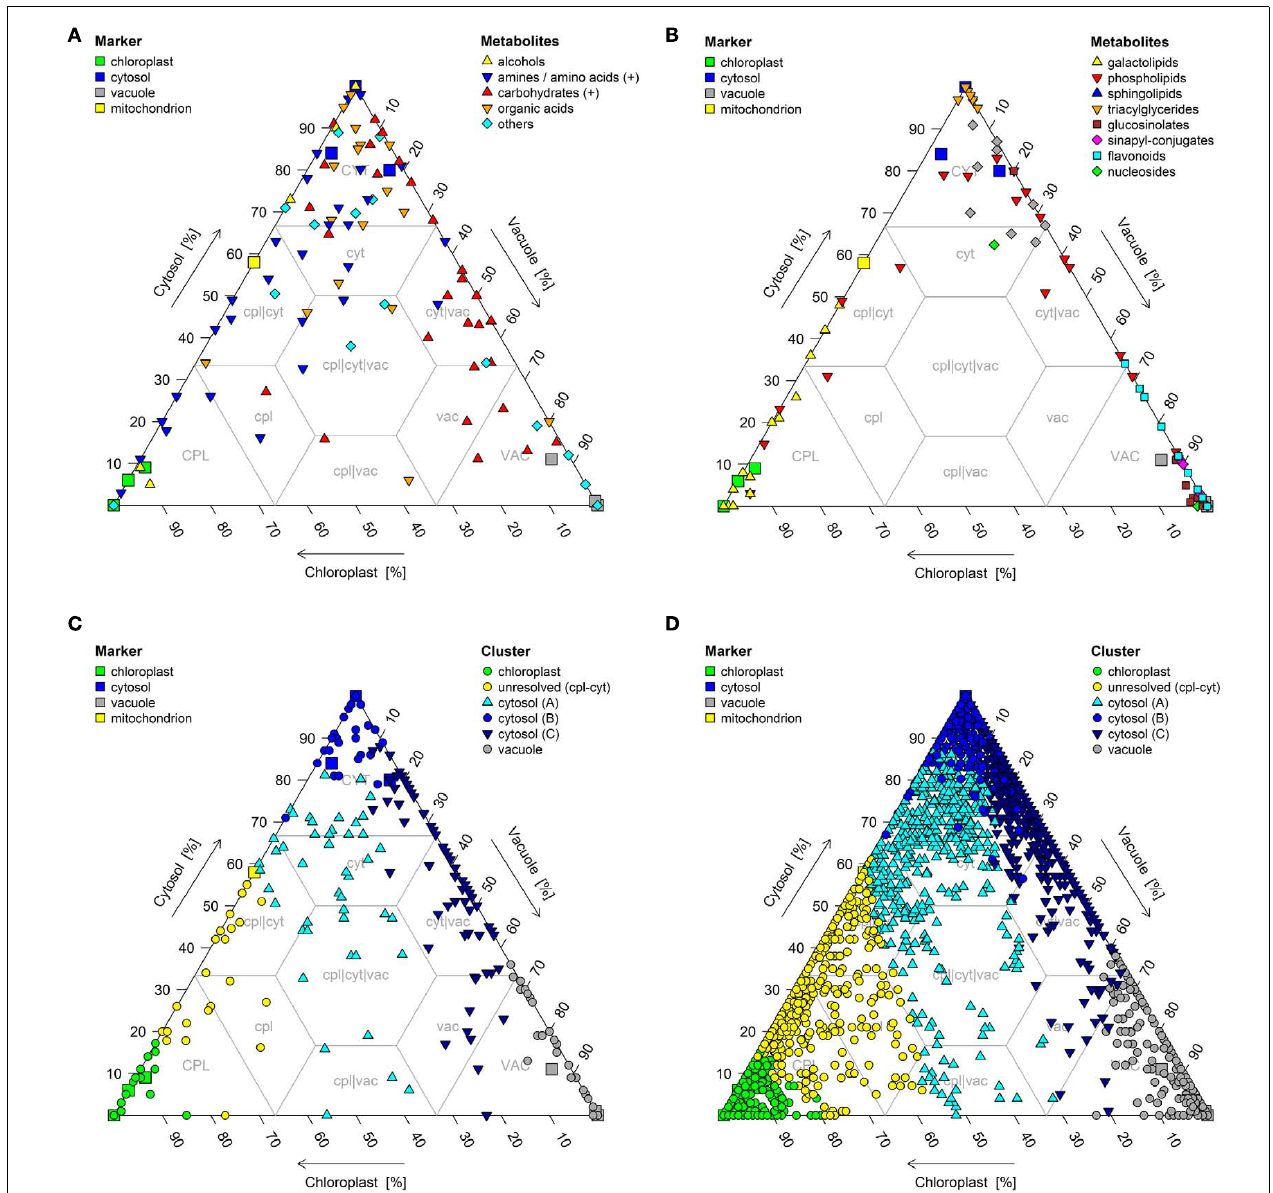
and the vacuole. (A,B) Chemical superclass assignments were overlaid on structurally identified metabolites and (C,D) k-medoids cluster assignments (cf. Krueger et al., 2011) were overlaid on all